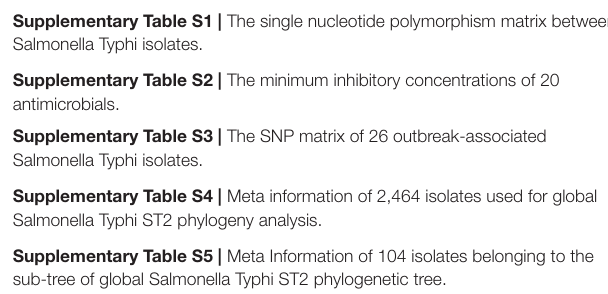
Supplementary Figure S2 | Virulence factor gene profiles of 26 S. Typhi isolates. The orange and red blocks indicate the isolates are from patients’ stools and water samples, respectively. The blue blocks indicate the presence of the virulence genes. Supplementary Table S1 | The single nucleotide polymorphism matrix between Salmonella Typhi isolates. Supplementary Table S2 | The minimum inhibitory concentrations of 20